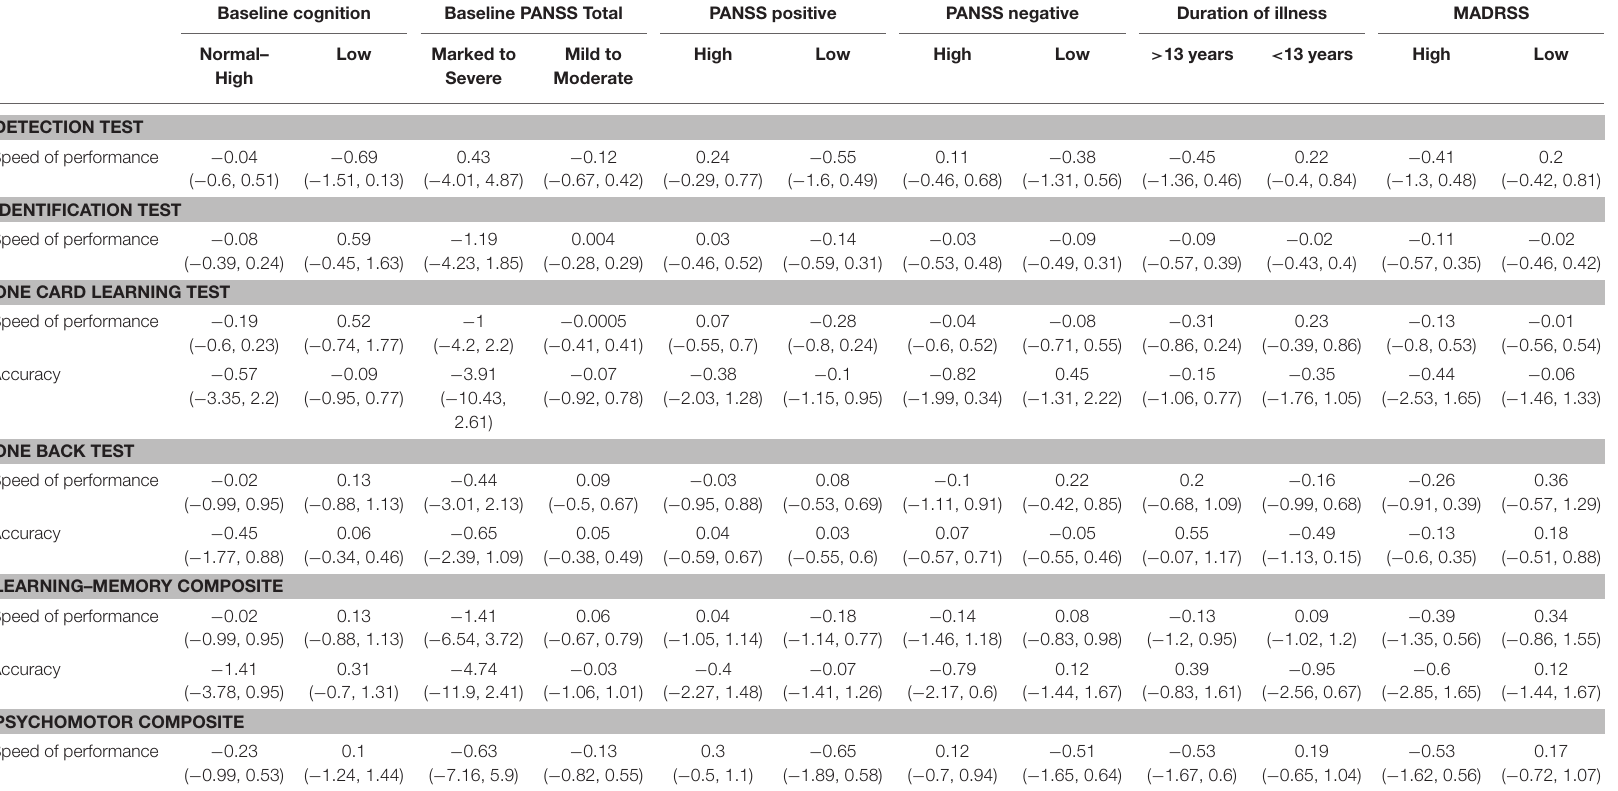
TABLE 3 | Subgroup analyses of cognitive outcomes (standardized Z scores) from baseline to end of